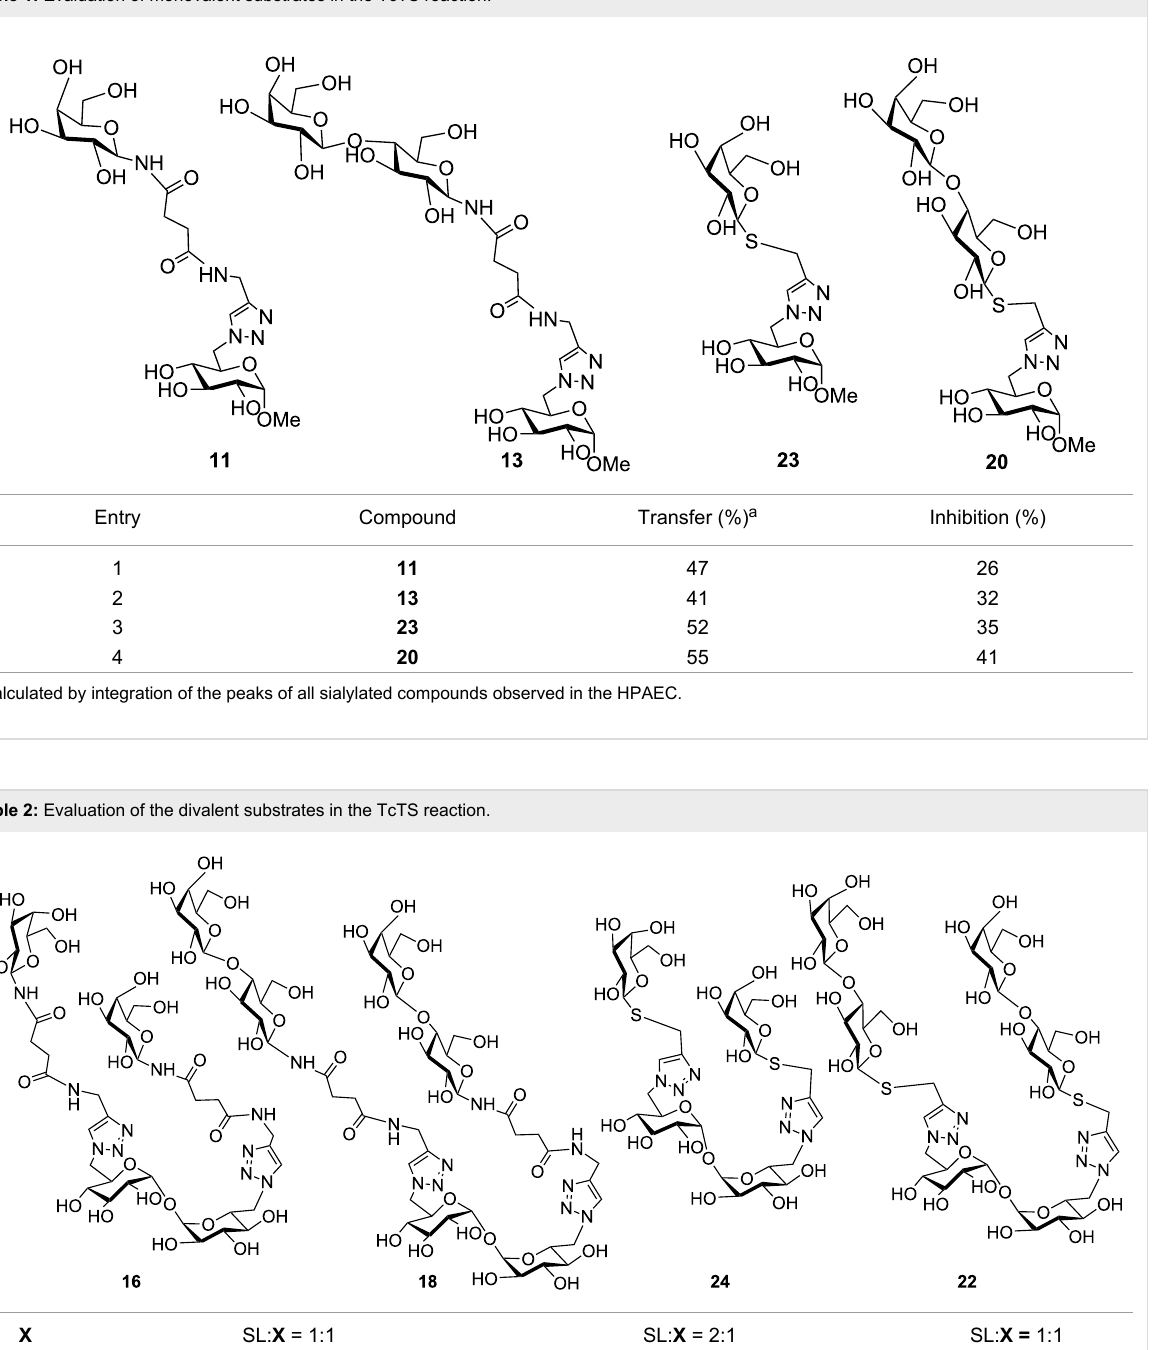
Table 1: Evaluation of monovalent substrates in the TcTS reaction.